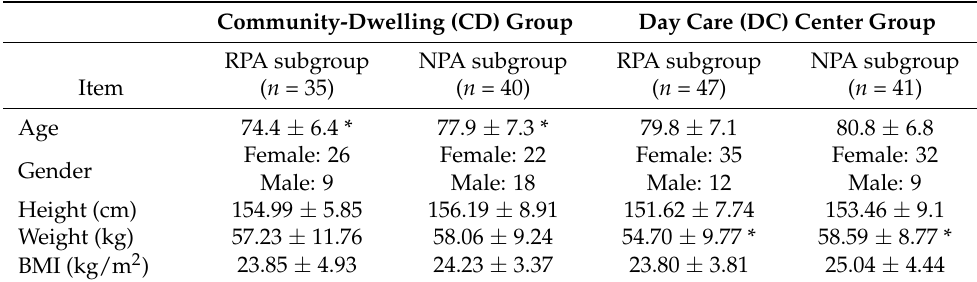
Table 1. Characteristics of the participants (average ±